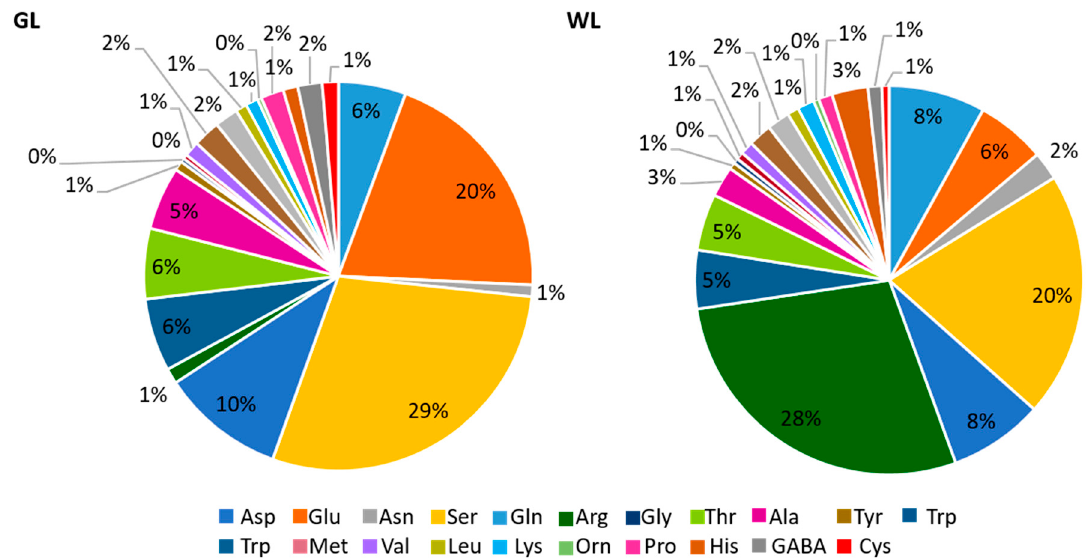
Figure 4. Distribution of free amino acids (AAs) in GL and WL of P. zonale plants. Proportions of different amino acids measured in GL ( left ) and WL ( right ) expressed in nmol g –1 FW are indicated. Glu-AA family. Genes involved in Pro biosynthesis (including four encoding delta- 1-pyrroline-5-carboxylate synthase) and Glu biosynthesis were induced in WL, while